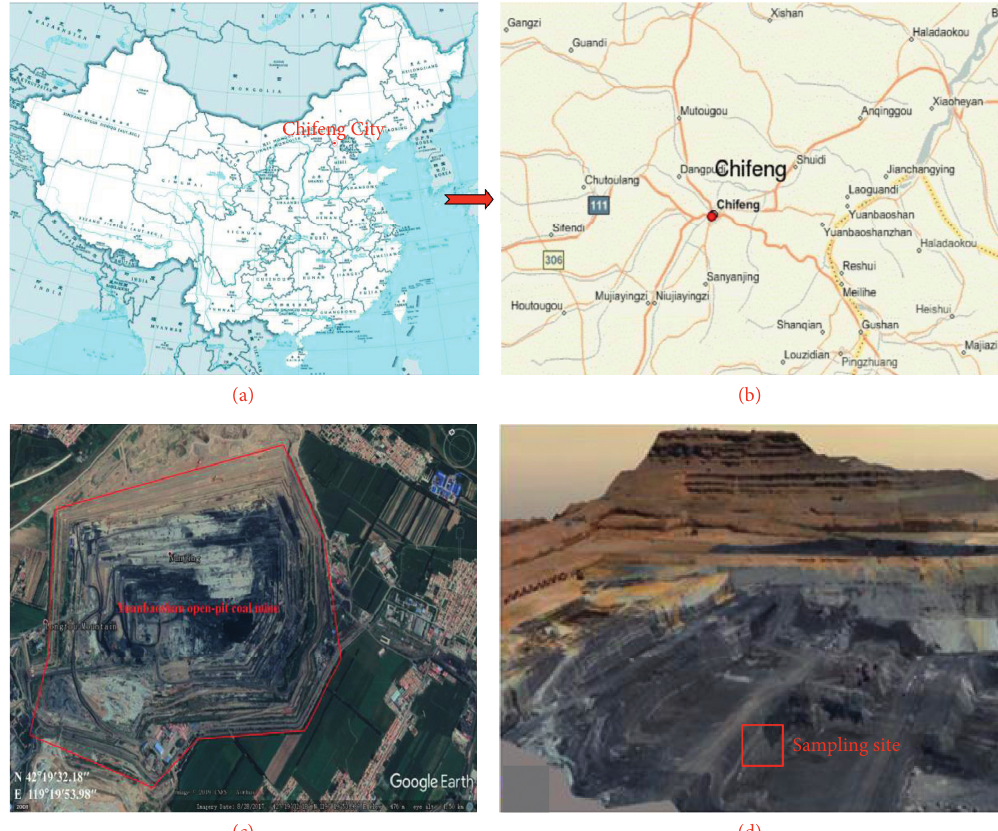
Figure 1: Location of coal sample collection: (a) location of Chifeng City on the map of China, (b) location of Chifeng City in Inner Mongolia, (c) the mine range of Yuanbaoshan open-pit mine on Google Earth map, and (d) sampling location.